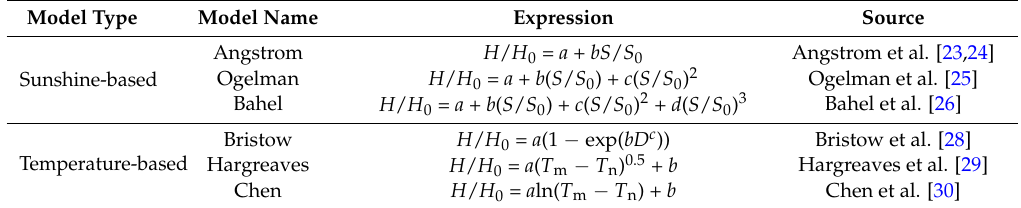
Table 8. Selected models for estimating daily solar irradiation on the TP and its surrounding regions. H is ground solar irradiation (MJ · m − 2 ), H 0 is the extra-terrestrial radiation (MJ · m − 2 ), S is the actual sunshine hours (h), and S 0 is the potential sunshine hours (h). D is the temperature difference, which can be calculated as D = T m − [ T n ( j ) + T n ( j + 1 )] /2, where T m is daily maximum temperature ( ◦ C), T n ( j ) and T n ( j + 1 ) daily minimum temperature ( ◦ C) on the current and following days respectively. Parameters a , b , c and d are empirical coefficients. H 0 and S 0 can be calculated according to the procedure described by Allen et al. [9], and the coefficients can be fitted with numerical iteration methods